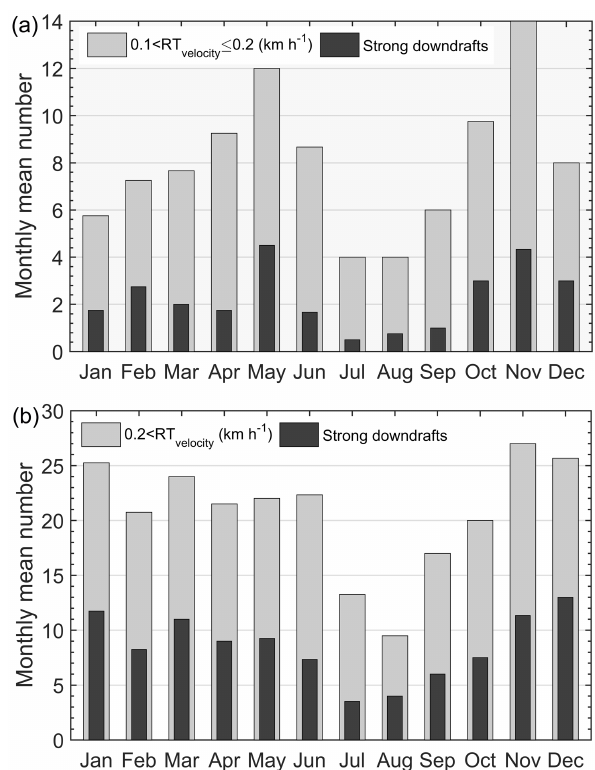
Figure 12. Four years (2012–2015) of radar-determined monthly mean number of rapid tropopause ascent (gray bands) and the cor- responding strong downdrafts just preceding the rapid tropopause ascent (black bands). (a) Gray bands: ascent of at least 0.6km and excursion velocity between 0.1 and 0.2kmh − 1 ; black bands: except for the criteria of gray bands, strong downdrafts that occurred pre- ceding the rapid RT ascent must exceed 0.5ms − 1 and pass through the RT layer. (b) Same as (a) but for the occasions when the ascent velocity is larger than 0.2kmh − 1 . According to the study here, the black bands in the histogram represent the occurrence of possible stratospheric intrusions